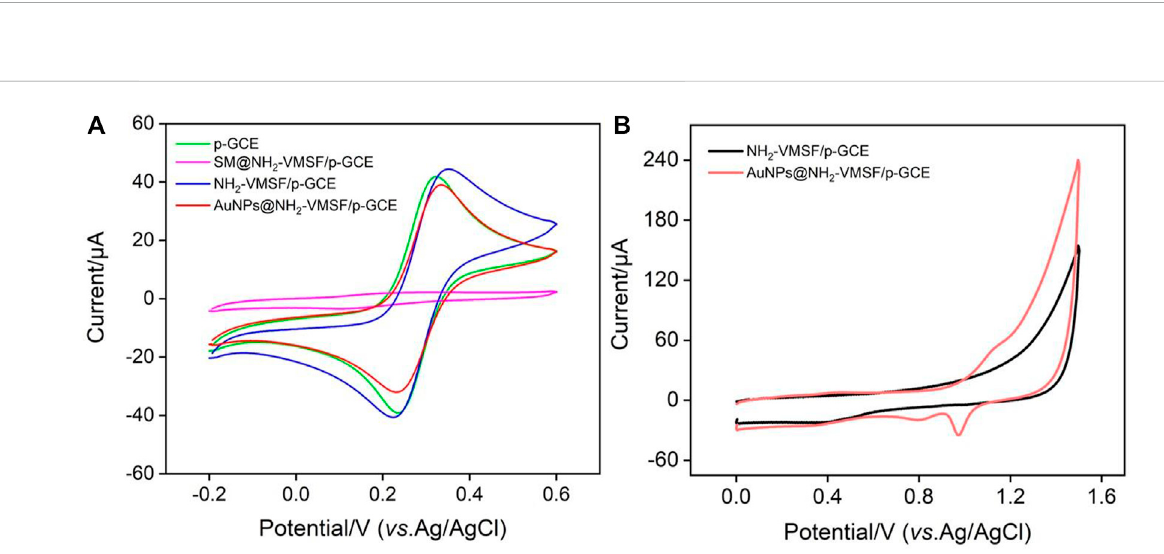
(B) CVsofNH 6 3 / 4- (2.5 mM) 2